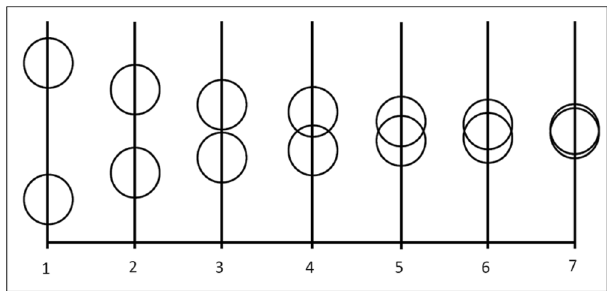
Figure 5. The Self-Other Closeness task as an adaptation of the single-item Inclusion of Other in the Self (IOS) scale developed by Aron et al. 50 . The pairwise circles illustrate the self (here the participant) and the other (here the robot). On the bottom, the subjective scale of the level of